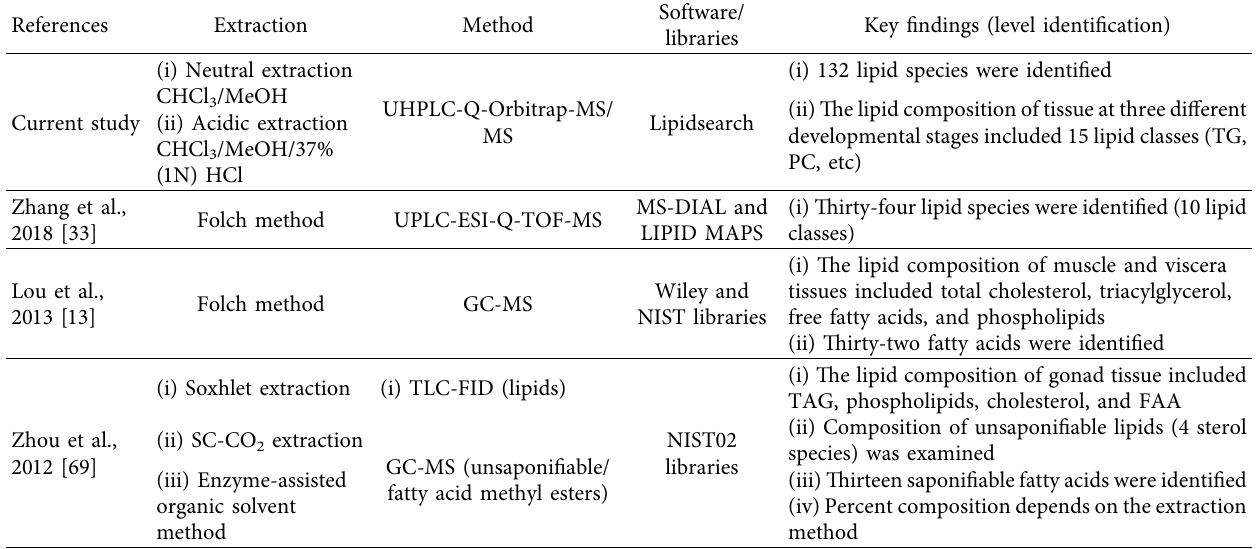
Table S1: List of identified lipids in tissue of abalone, Haliotis discus hannai at different developmental stages (swimming veliger larvae, juvenile, mature). Table S2: List of identified lipids in hemolymph of female and male abalone, Haliotis discus hannai . Table S3: List of the normalized area of lipids in tissue of abalone, Haliotis discus hannai at different de- velopmental stages (swimming veliger larvae, juvenile, mature). Table S4: List of normalized area of lipids in he- molymph of female and male abalone, Haliotis discus hannai. Figure S1: Total ion current (TIC) chromatogram of the tissue samples: (a) Swimming veliger larvae, (b) Juvenile, (c) Mature. Figure S2: Total ion current (TIC) chromatogram of the hemolymph samples: (a) Female, (b) Male. Figure S3: PCA score plots of (a) tissues in three different developmental stages, (b) female and male he- molymph. Figure S4: The detailed heatmap of abalone tissue. ( Supplementary Materials